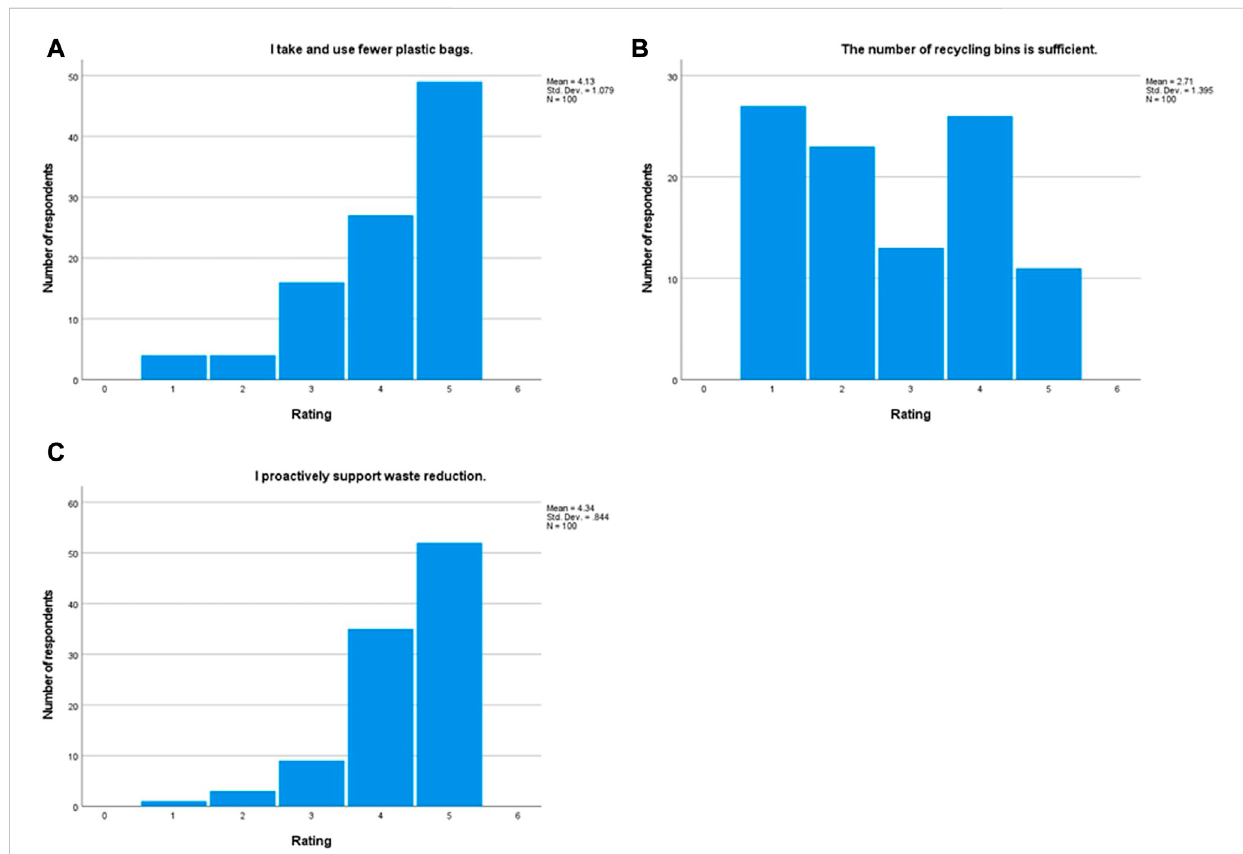
FIGURE 6 Rating of respondents about (A) taking and using fewer plastic bags, (B) the adequacy of recycling bins, and (C) tendency of respondents to support waste